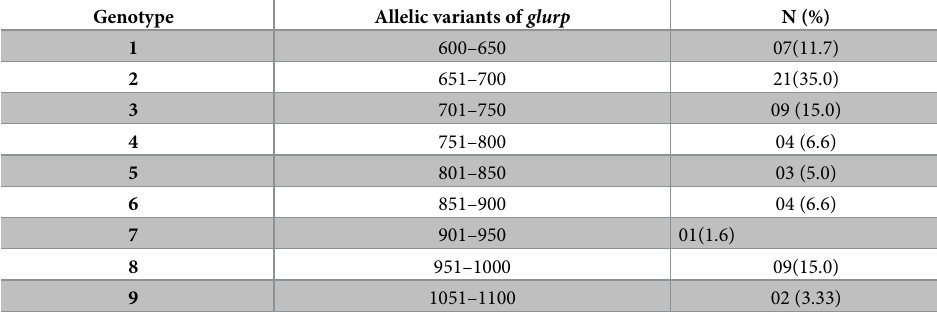
Table 4. Distributions of allelic variants of glurp RII repeat region of P . falciparum populations in Khyber Pakh- tunkhwa, Pakistan. Genotype Allelic variants of glurp